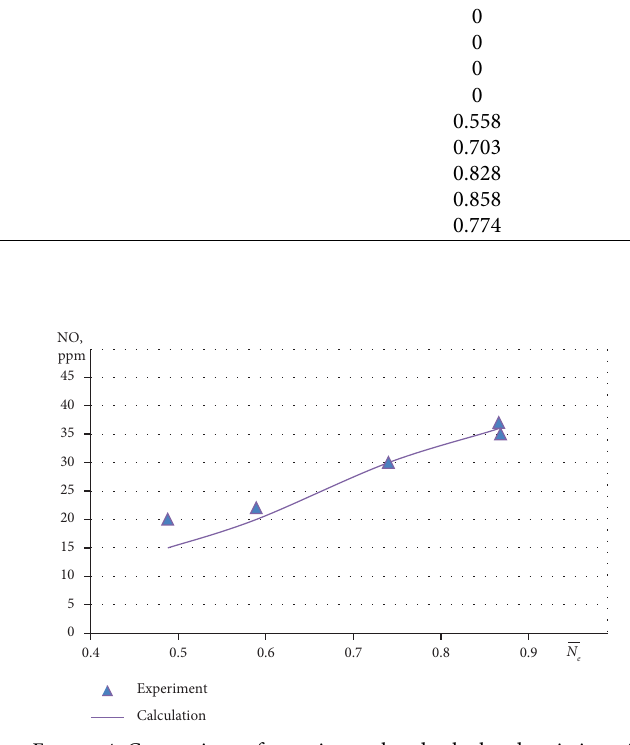
Figure 4: Comparison of experimental and calculated emission of nitrogen oxides.